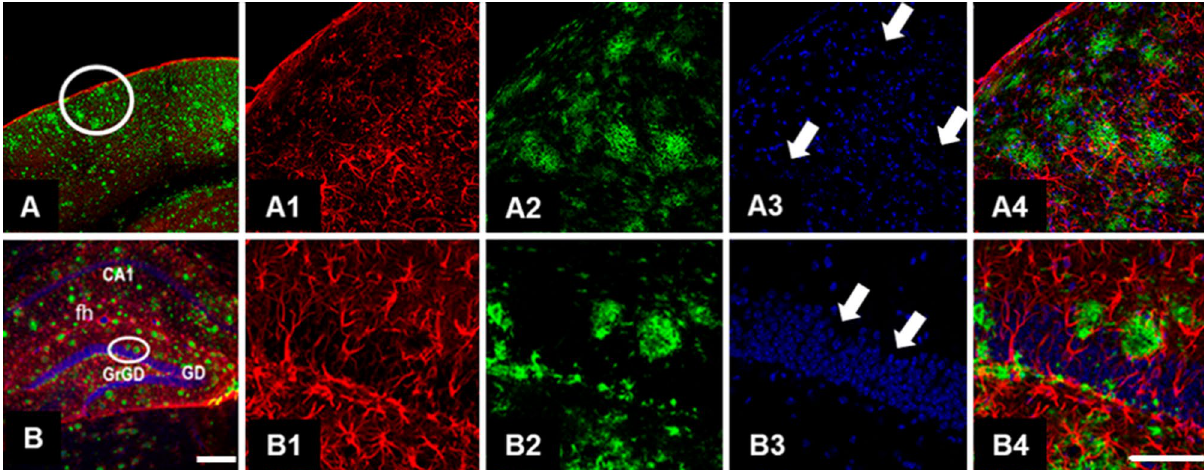
Figure 4. Presence of clusters of reactive astrocytes surrounding Aβ-deposits in APPswe/PS1dE9 mouse cortex and hippocampus (representative images). ( A ) Distribution of Aβ-deposits in cortex coronal section 50 µm of 24-months old AD (APPswe/PS1dE9) mouse (×10). ( A1 ) Reactive astrocytes (×40). ( A2 ) Distribution of Aβ-deposits, (×40). ( A3 ) Cell nuclei (×40), arrows indicate the loss of cells in the same locality where there are Aβ-deposits, and the presence of reactive astrocytes around and between the Aβ plaques. ( A4 ) Merged ( A1,A2,A3 ). ( B ) Distribution of Aβ-deposits in hippocampus coronal section 50 µm of 24-month old AD (APPswe/PS1dE9) mouse (×10). ( B1 ) Reactive astrocytes in granular layer of the gyrus dentate of hippocampus (×40). ( B2 ) Distribution of Aβ-deposits, (×40). ( B3 ) Cell nuclei (×40), arrows indicate the loss of cells in the same location where there are Aβ-deposits, and the localization of reactive astrocytes around and between the Aβ plaques. ( B4 ) Merged (B1,B2,B3) . Coronal section 50 µm. Anti-GFAP (red), anti-Aβ (green), bismencimide (blue). Bars 1 cm (A,B) and 0.5 cm (A1–A4, B1–B4) .